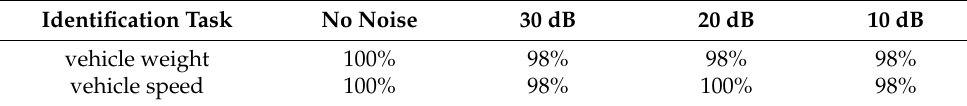
Table 11. Model Identification results under different noise